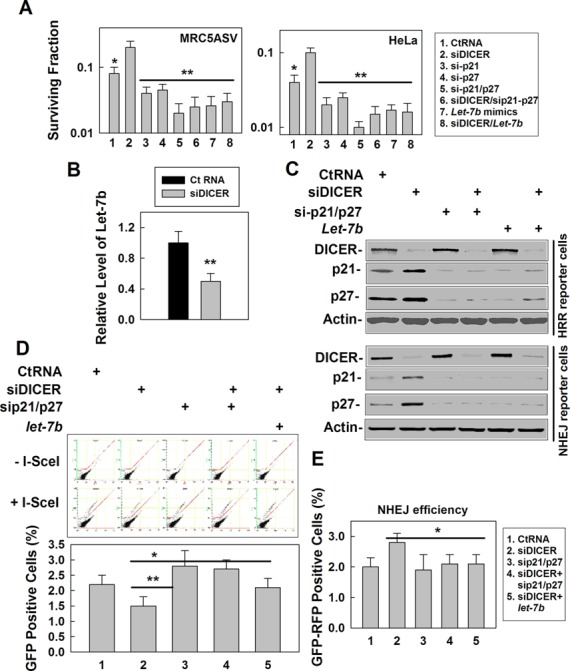
The prolonged G1/S transition results in decreased HRR and cellular resistance to CPT treatment. (A) The effects of let-7b mimics, si-p21, si-p27 or si-p21/si-p27 on the sensitivities of cells with DICER knockdown to CPT. MRC5SV and HeLa cells were treated with siDICER and with or without let-7b mimics, si-p21, si-p27 or si-p21/si-p27 for 60 h. The cells were collected, plated, treated with CPT for an additional 18 h and then used in the clonogenic assay. The data presented are the mean ± SD from three independent experiments that the authors carried out, *P < 0.05, **P < 0.01 versus bar 2. (B) The relative level of let-7b was detected in the HRR reporter U2OS cells. The cells were treated with CtRNA or siDICER for 48 h and then transfected with I-SceI for an additional 48 h. The cells were collected for RNA extraction and the let-7b levels in siDICER treated cells were calculated as a propotion of the let-7b level in the cells treated with CtRNA. The data presented are the mean ± SD from two independent experiments that the authors carried out with triple sets for each experiment: **P < 0.01. (C) The U2OS HRR reporter or the 293FT NHEJ reporter cells were treated with siDICER with or without, let-7b or si-p21/si-p27 for 48 h, the cells were then transfected with I-SceI for an additional 48 h. The cells were collected for immunoblot detection. Similar data were obtained from two independent experiments that the authors carried out. (D) HRR efficiency was detected in the U2OS HRR reporter cells treated with siDICER, plus si-p21/si-p27 or let-7 mimics for 48 h. The cells were then transfected with I-SceI for an additional 48 h. The GFP signals of the cells were detected with flow cytometry. The data presented are the mean ± SD from three independent experiments that the authors carried out, *P < 0.05; **P < 0.01. (E) After the 293FT NHEJ reporter cells were treated with siDICER, plus si-p21/si-p27 or let-7b mimics for 48 h, they were transfected with I-SceI for an additional 48 h. The fluorescent signals of the cells were detected with flow cytometry. The cell fluorescent (RFP) only upon repair of I-SceI-induced DSBs by NHEJ. The data were obtained from three independent experiments that the authors carried out, *P < 0.05.